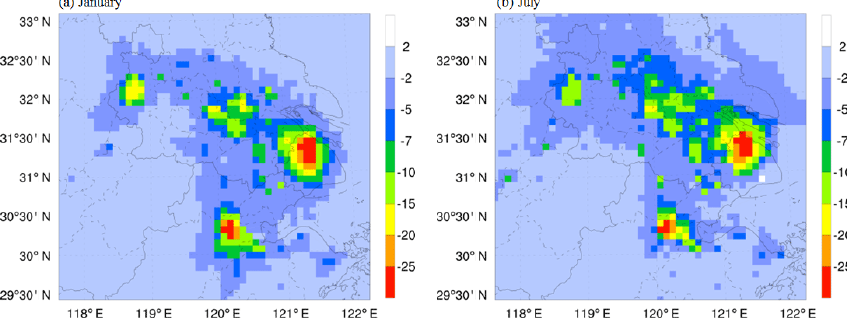
Figure 10. The spatial distributions of monthly averaged differences for PM 10 between ADDAH and NONAH (ADDAH-NONAH). Differ- ences that are non-significant under the 95% confidence level (Student’s t test) are masked